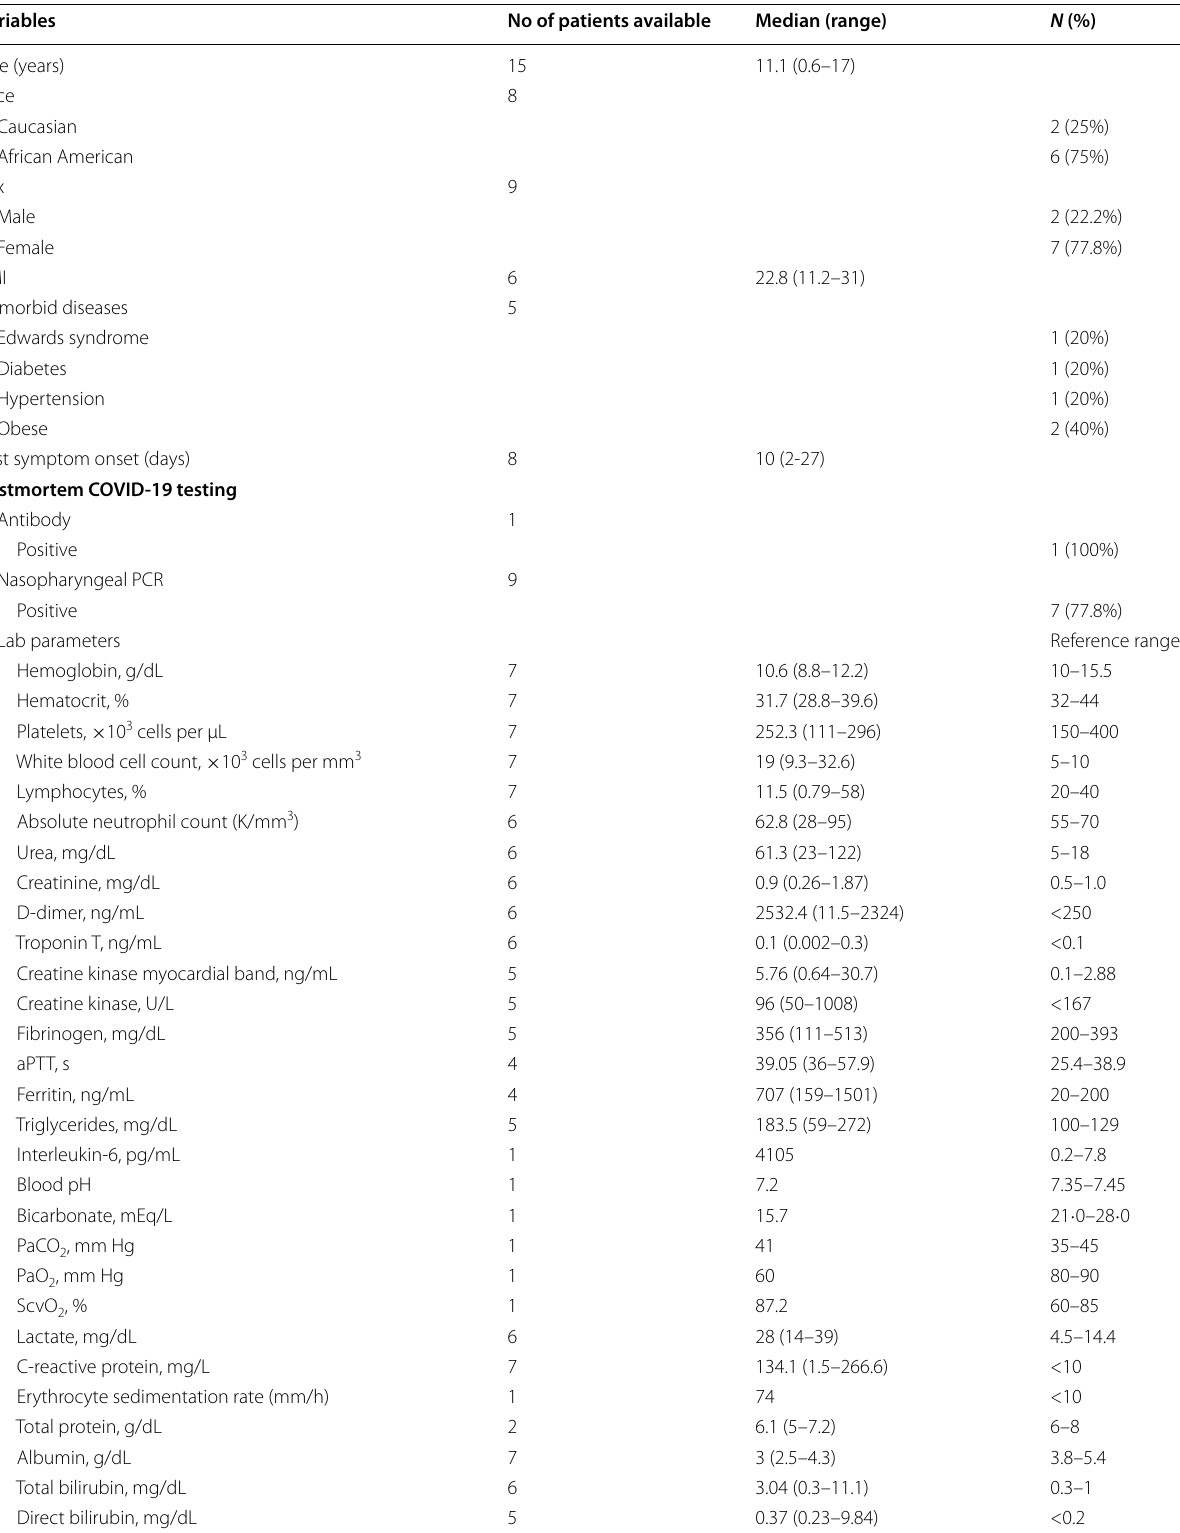
Table 2 Characteristic of patients